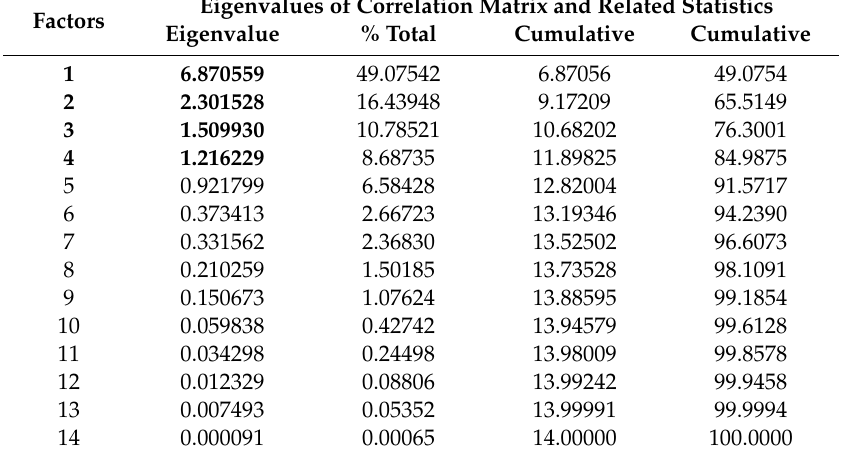
Bold values represent the factors that at least explain one variable. Table A2. PCA: factor weight of the